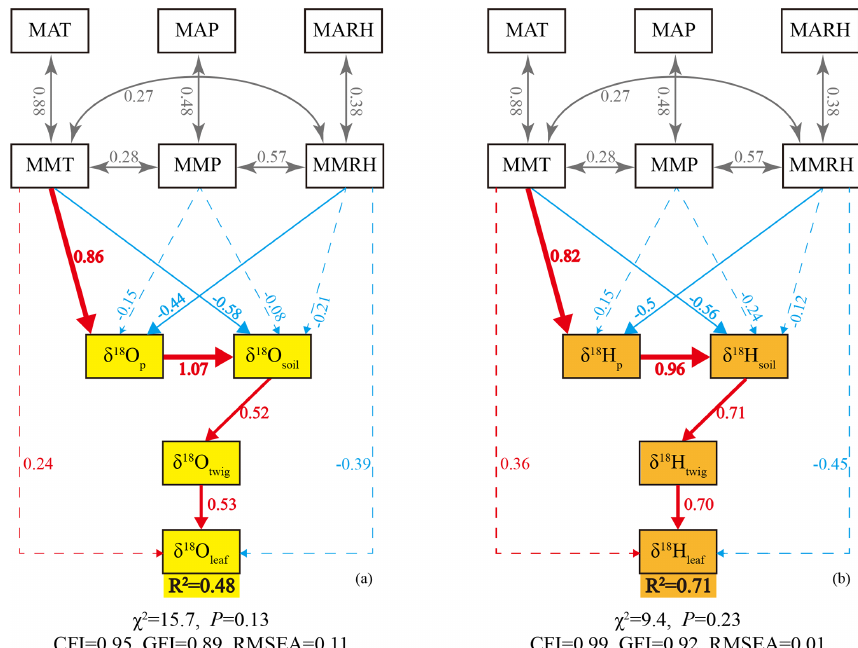
Figure 6. Structural equation model (SEM) of leaf water δ 18 O (a) and δ 2 H (b) values. The structural equation models considered all plausible pathways. Solid lines indicate significant positive (red) or negative (blue) effects, and dashed lines indicate non-significant effects. Grey lines indicate correlations between two variables. Numbers on the arrow indicate significant standardized path coefficients, proportional to the arrow width. The coefficients of determination ( R 2 ) represent the proportion of variance explained by the